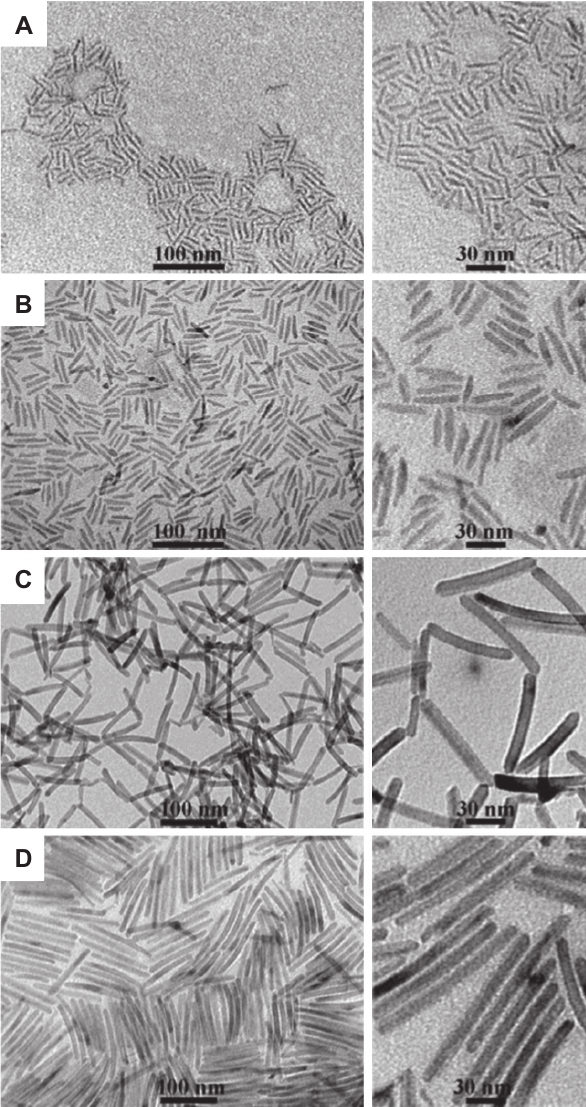
nanorods prepared by a surfactant- 2